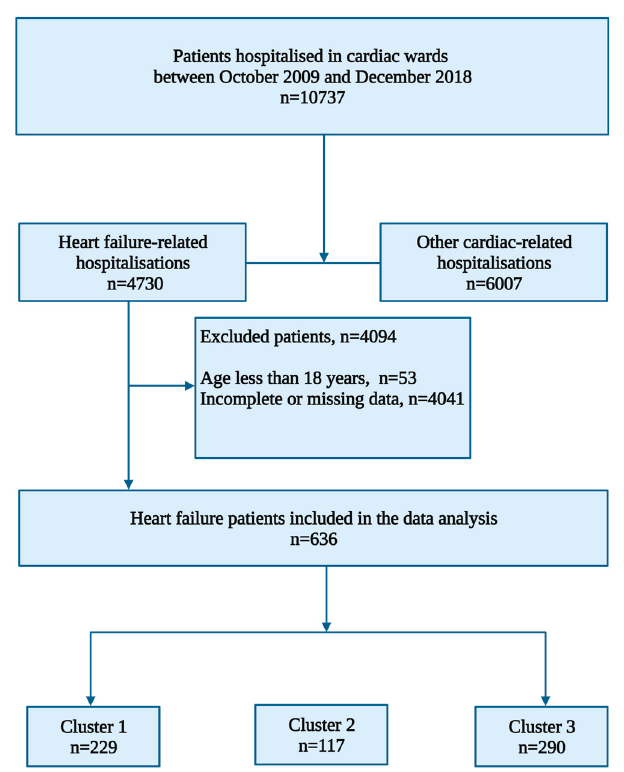
Figure 1. Flow chart showing heart failure patient selection for clustering. Table 2. Baseline demographic and clinical characteristics of the study patients stratified according to the left ventricular ejection fraction.